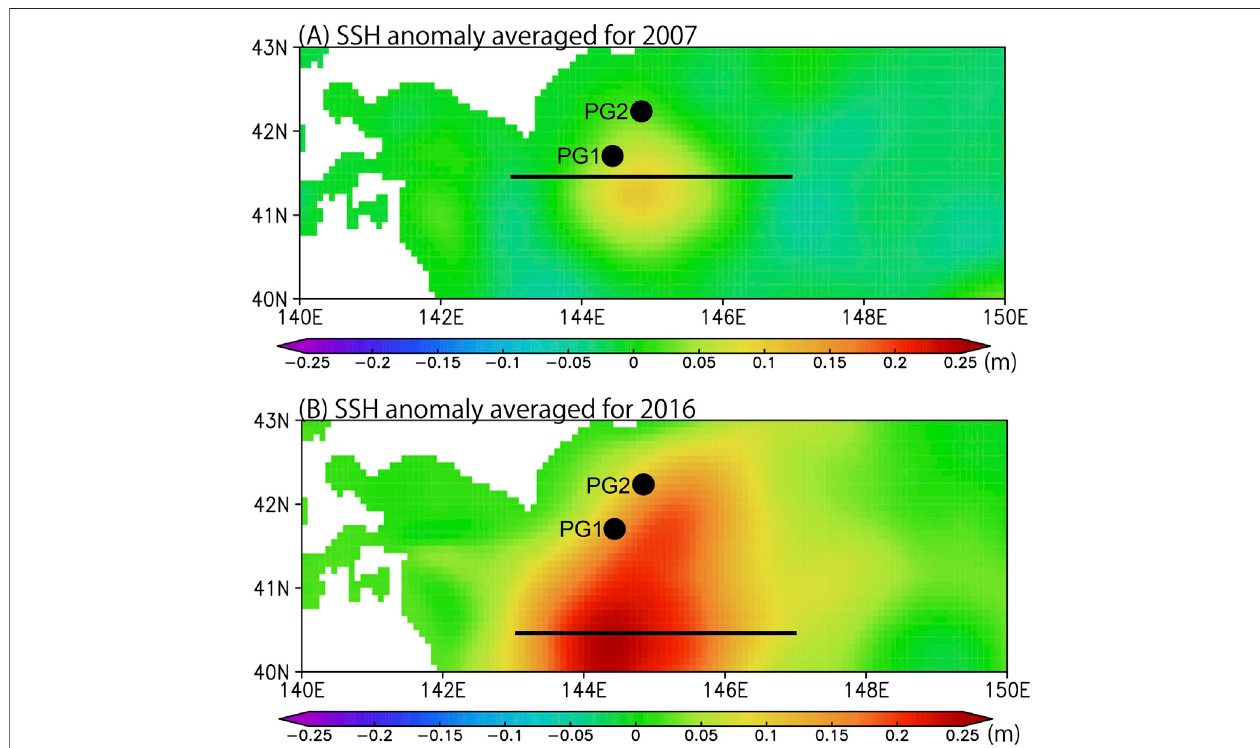
FIGURE 3 | (A) Spatial distribution of the yearly averaged SSH anomaly for the year 2007. The unit is m. The black horizontal line along 41.5 ° N denotes the longitude range for the longitude-depth diagram of σ θ in Figure 4A . Black circles denote the location of PG1 and PG2. (B) Same as (A) but for the year 2016. The black horizontal line along 40.5 ° N denotes the longitude range for the longitude-depth diagram of σ θ in Figure 4B .